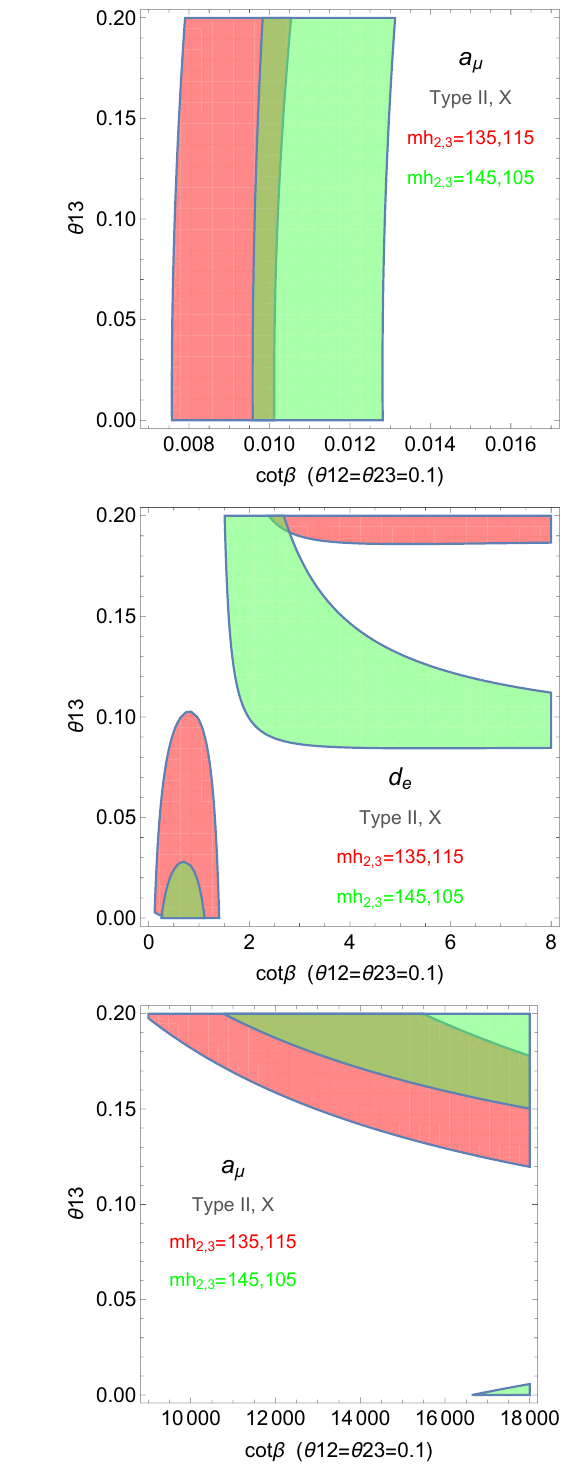
Figure 11 . Regions surviving d e bounds while producing a (cid:22) in Type-I,Y (left) and Type II,X (right) for mid-range m h masses (in GeV) and (cid:12)xed values of (cid:18) 12 and (cid:18) 23 . Note that in Type-I,Y 2 ; 3 plots by changing m h masses, it is possible to cover the whole plane. 2 ; 3